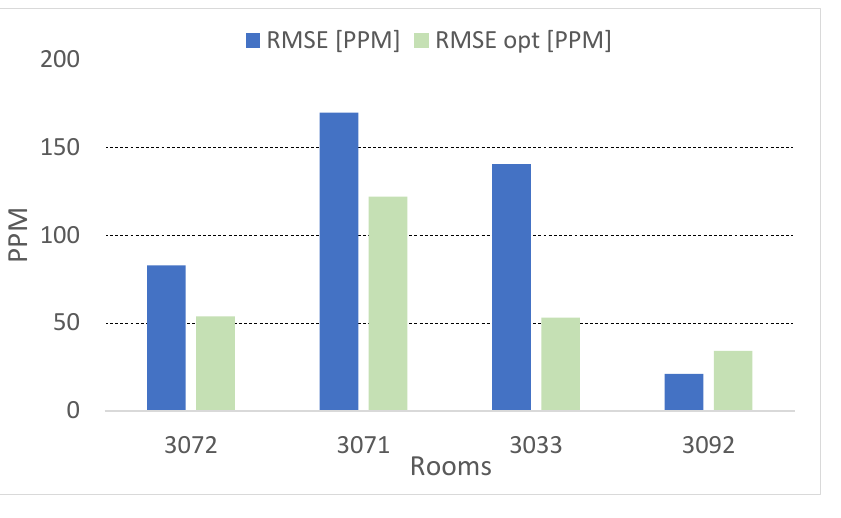
Figure 13. Mean absolute error for the air temperature: comparison calibrated model vs. optimized model.